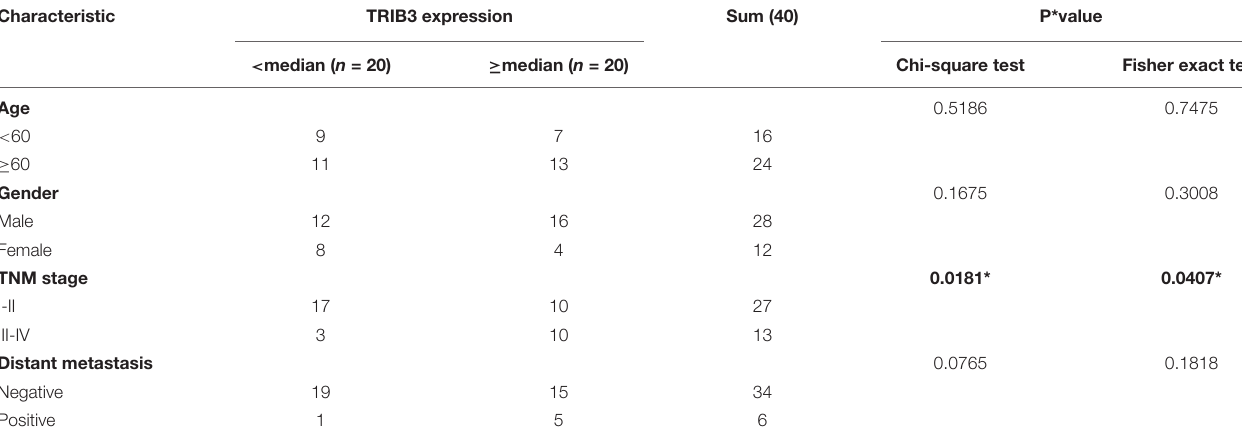
TABLE 3 | The clinical significance of TRIB3 expressions in bladder